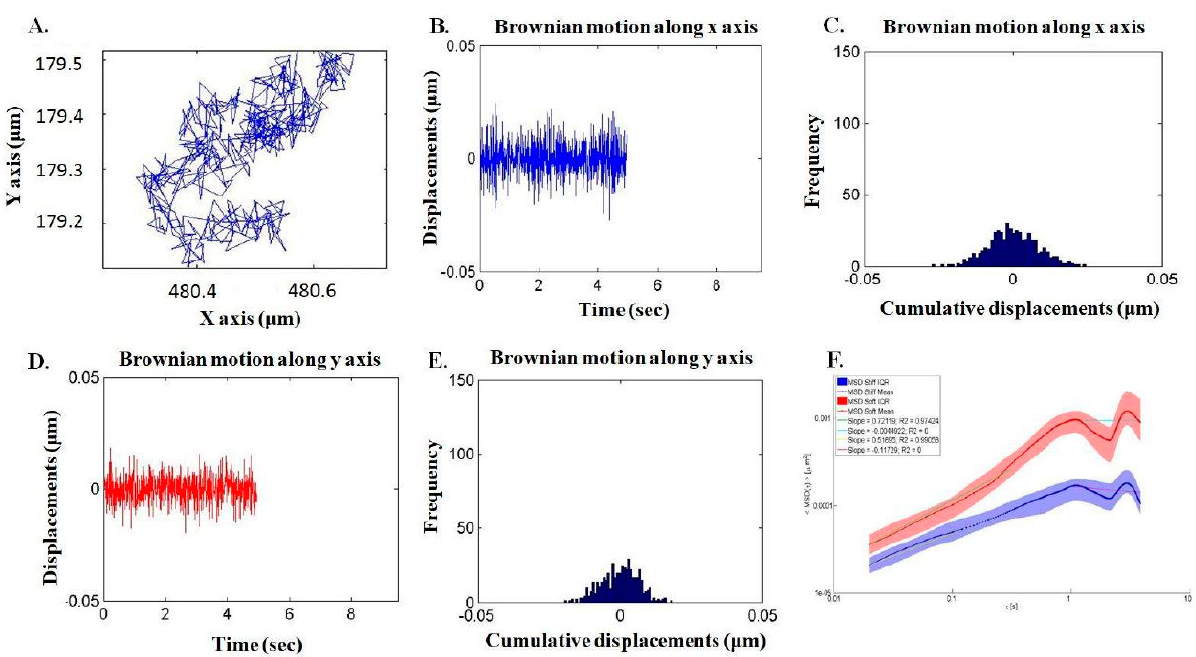
Figure 5. Computation of the hMSCs mechanical properties by passive microrheology. ( A ) The Brownian motion of beads in hMSC of interest was traced and projected to XY-plain. ( B , D ) In respect to time, the motion along x and y axis was depicted individually. ( C , E ) All documented displacements were integrated and expressed with frequency to calculate mean square displacement (MSD). ( F ) Young’s modulus was yielded by applying MSD into generalized Einstein-Stokes equation.